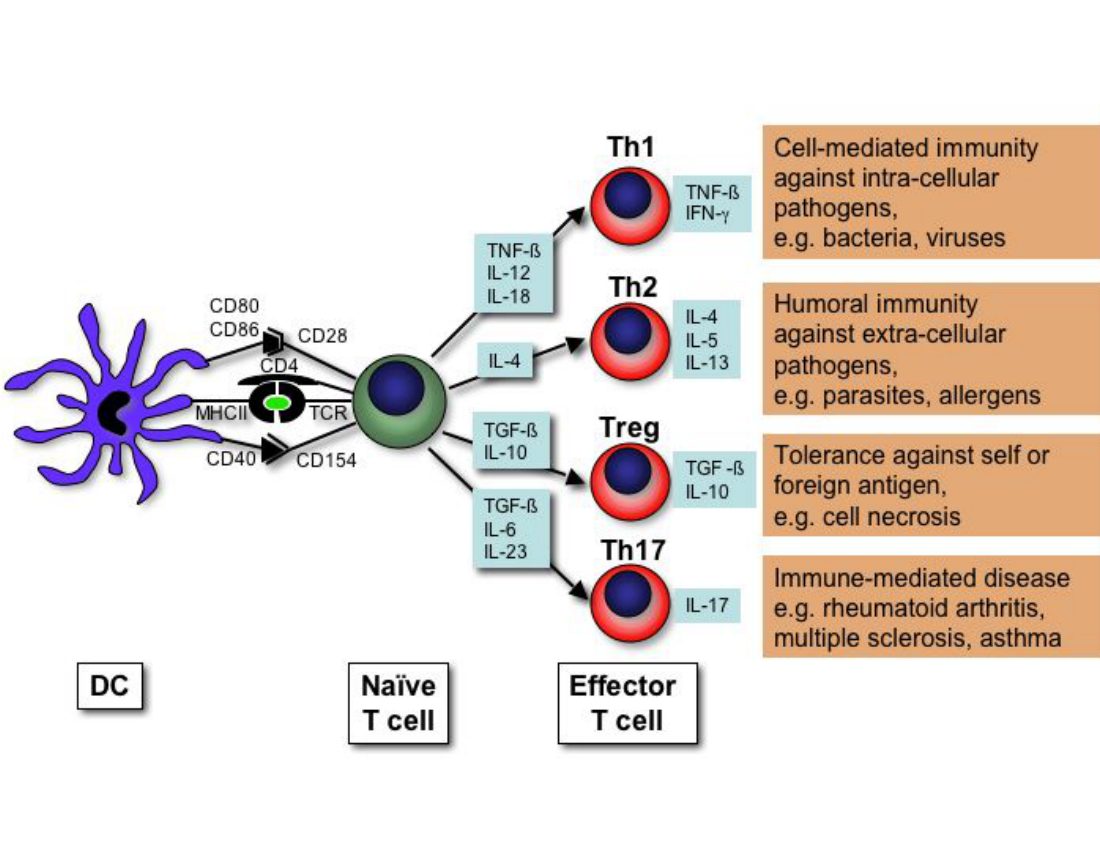
Differentiation of naïve T cells into effector T cells. In lymph nodes, DCs present antigen-derived peptide fragments to naïve T cells on MHC class II molecules in combination with co-stimulatory molecules and in the presence of cytokines. Following cognate interaction with DCs, naïve T cells may differentiate into several effector T cell populations that play a role in immunity and immune-mediated